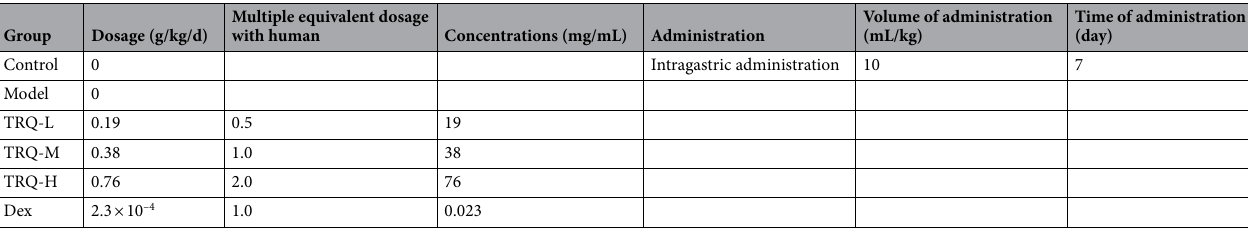
Fig. 3A. GOBP mainly contained the response to LPS, the response to molecules of bacterial origin, and the